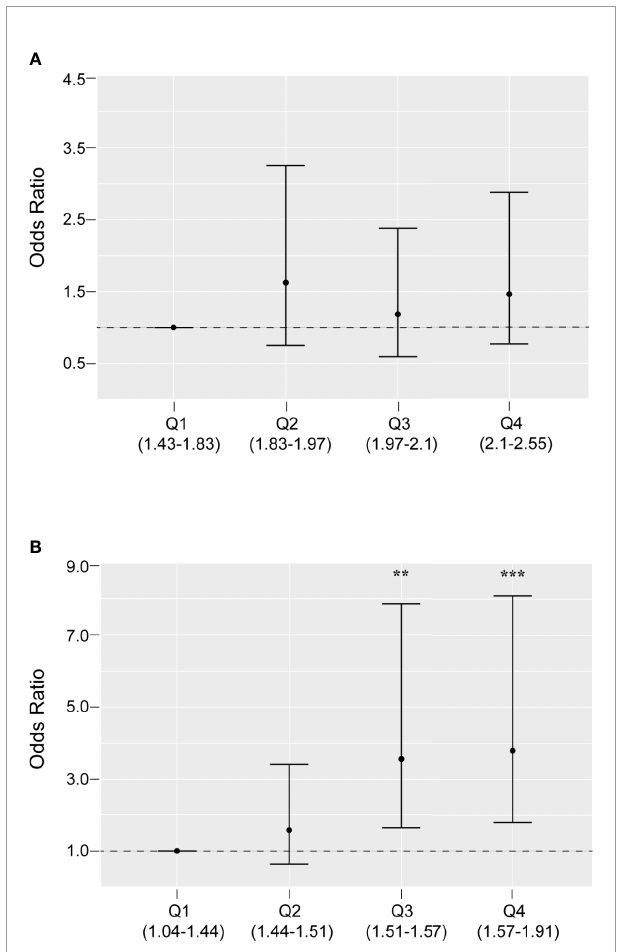
FIGURE 2 | Odds ratios and 95% con fi dence intervals for PCOS by quartiles of mitochondrial DNA copy number (A) and 4977 bp deletion rate (B) , adjusted for body mass index, luteinizing hormone/follicle-stimulating hormone ratio, and testosterone level. **P < 0.01, ***P <